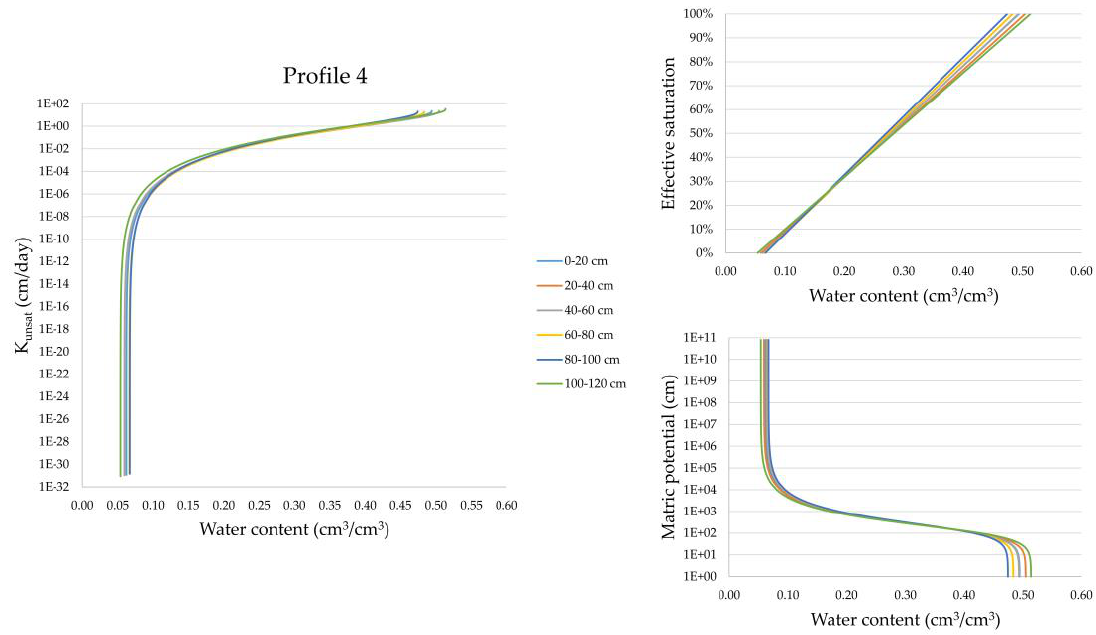
Geosciences 2019 , 9 , x FOR PEER REVIEW Figure 5. SWRCs, e ff ective saturations, and unsaturated hydraulic conductivities in soil profile 3. Figure 5. SWRCs, effective saturations, and unsaturated hydraulic conductivities in soil profile 3.